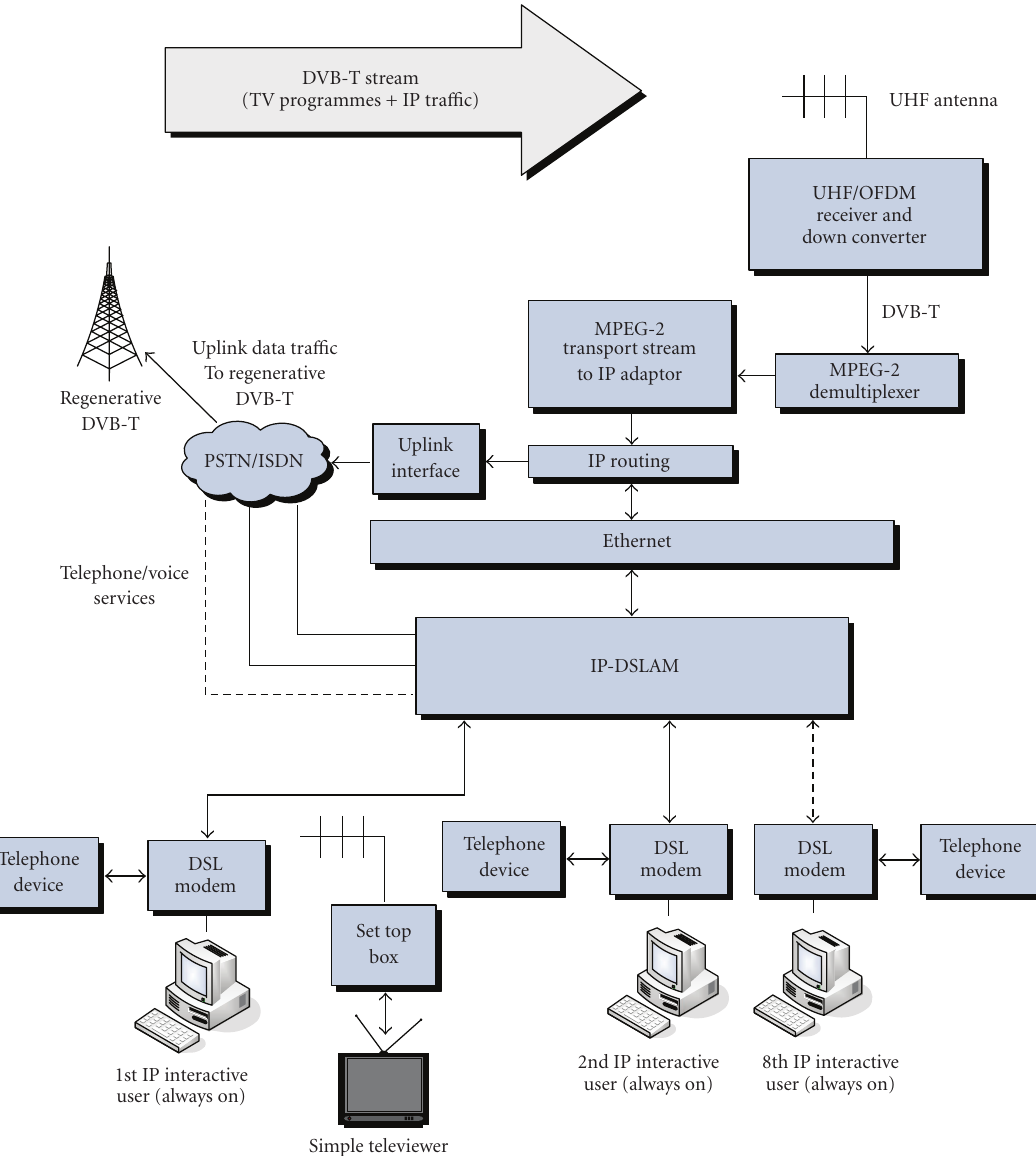
Figure 5: Rural-based